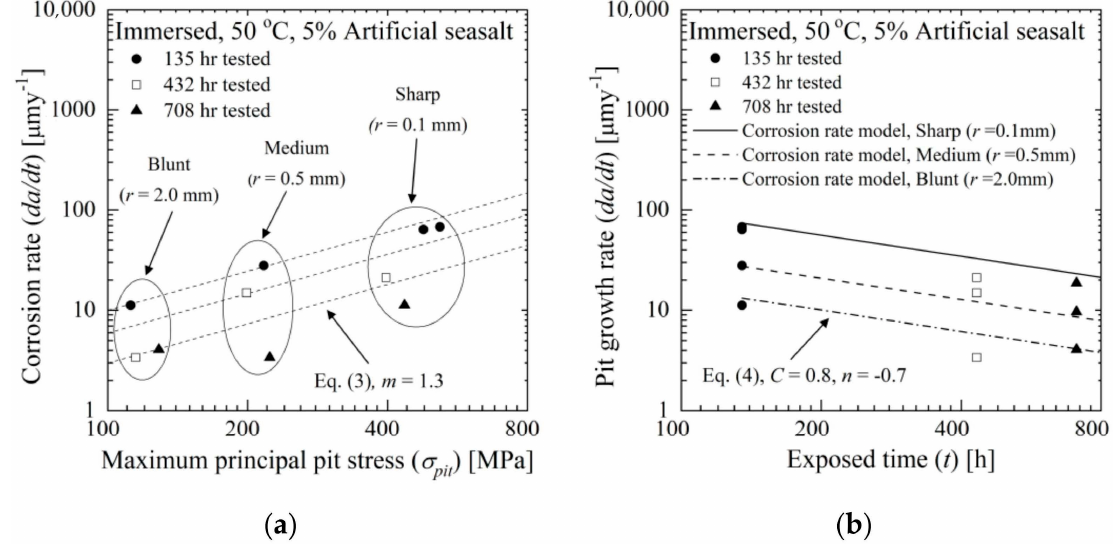
Figure 8. Changes in the calculated corrosion rates (in Table 3) with respect to ( a ) the maximum principal pit stress and ( b ) the exposed time. The figures are shown in the log-log